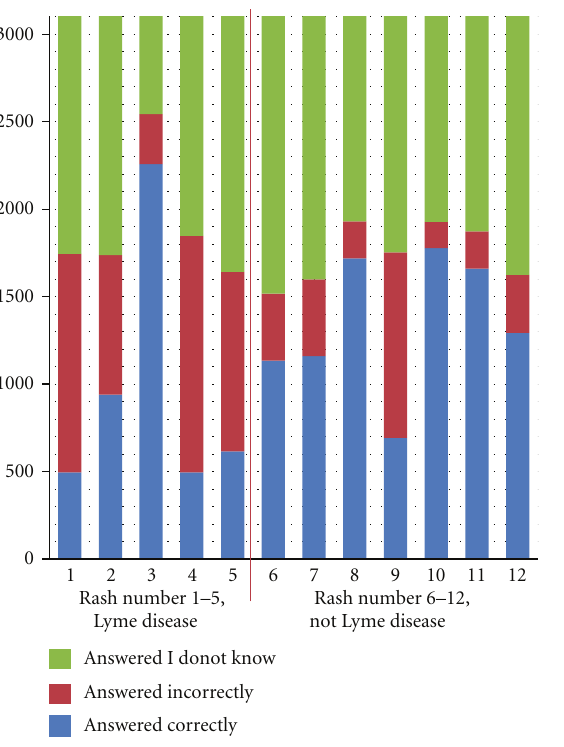
Figure 3: Responses to each rash of those who answered each question in the Lyme disease rash